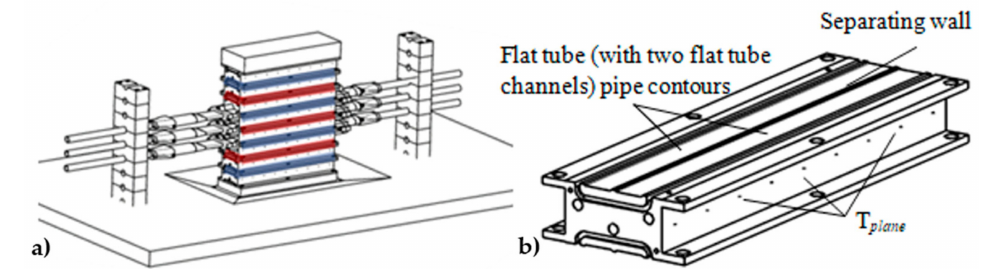
Figure 4. Test section with eight stacked aluminum half shells and supply pipes ( a ) and enlarged view of one of the half-shells ( b ) (for clarity, only three of the seven supply pipes are shown). Reproduced with permission from [16], published by Elsevier